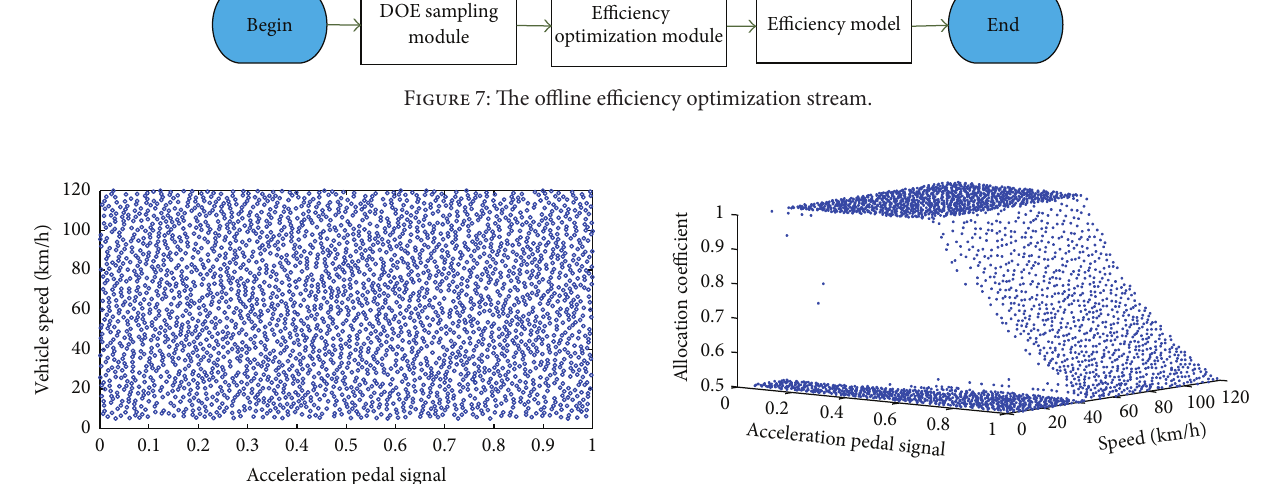
Figure 9: Allocation coefficients optimization